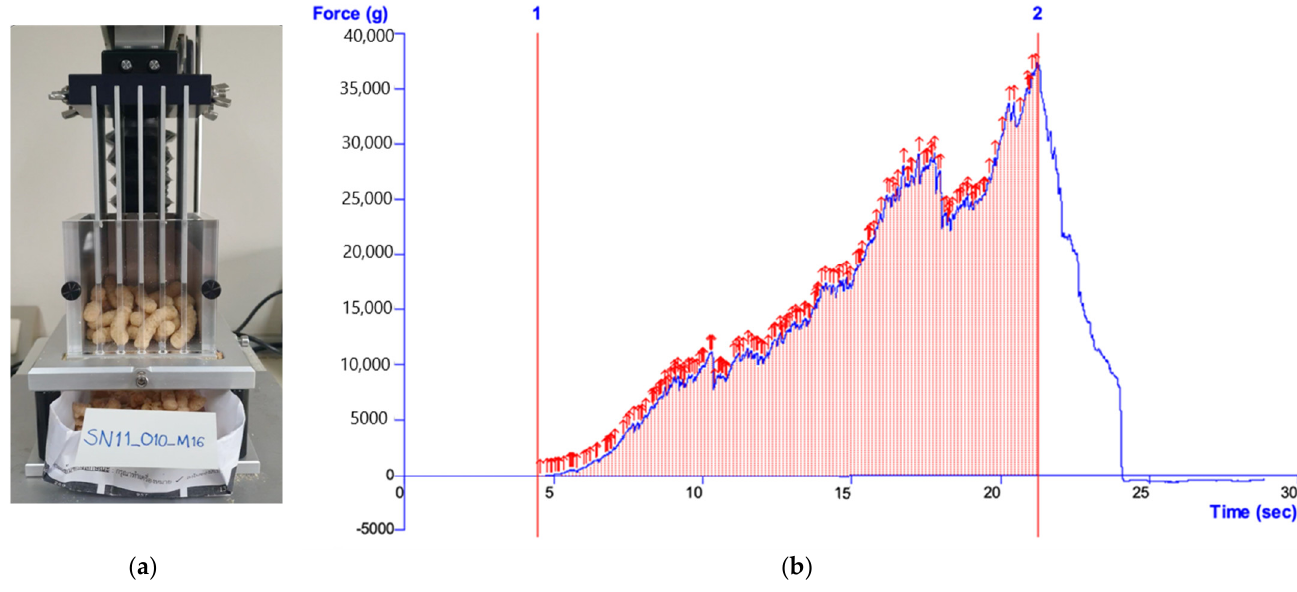
Figure 2. ( a ) Instrumental set up of the fracturability test consisting of a 5-blade Kramer Shear Cell mounted to a TA-XTplus ® Texture Analyzer; ( b ) Schematic representation of a typical force- deformation curve for crispness (peak) and toughness (g.sec).